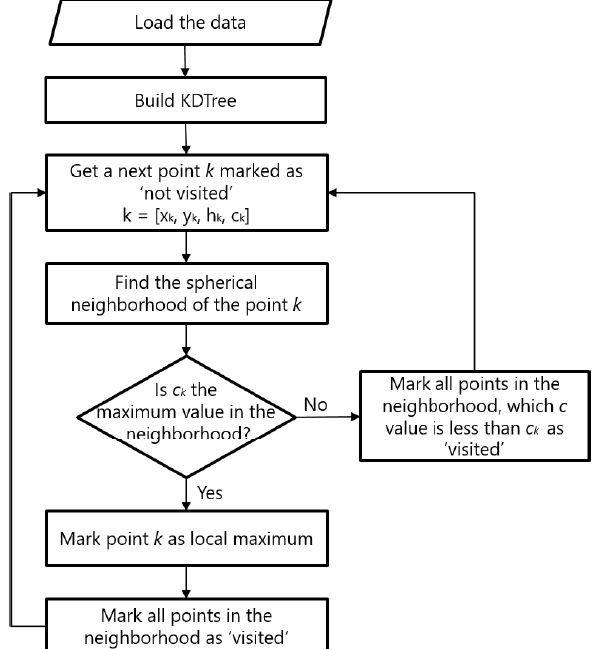
Figure 2. Local maxima detection